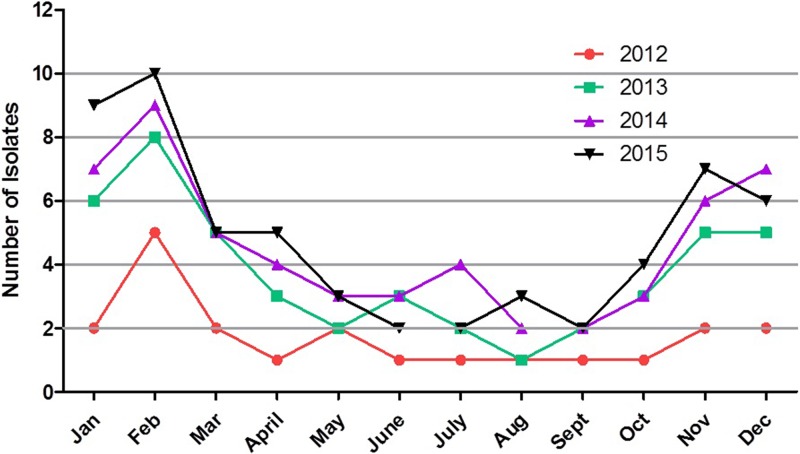
Seasonal variation in the number of confirmed meningitis cases was examined from 2012 to 2015.A greater number of confirmed meningitis cases occurred during 2015 than occurred during any other year. The highest number of confirmed meningitis cases occurred during February 2015. The monthly prevalence of confirmed meningitis was, for the most part, lower in 2012, except for during the month of February. It was notable that the seasonal distribution indicated that the number of positive CSF cultures decreased during the rainy season (May—October) in Southwest China.